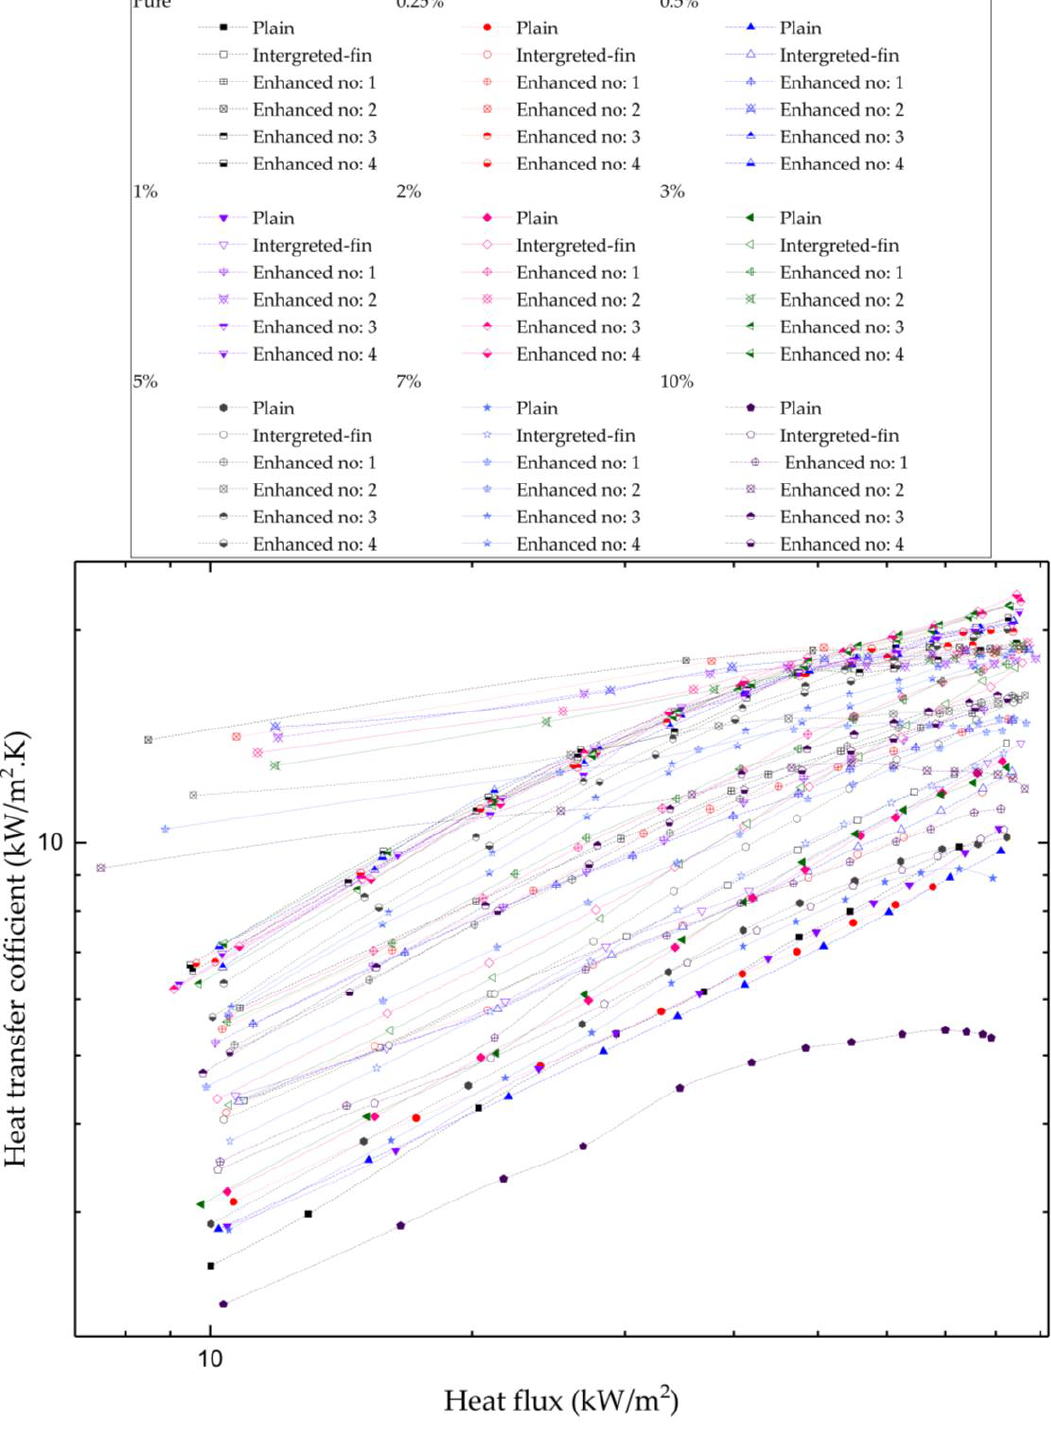
Figure 9. Performance of R-134a at a T sat = 6°C for HTCs with different lubrication concentrations [47].